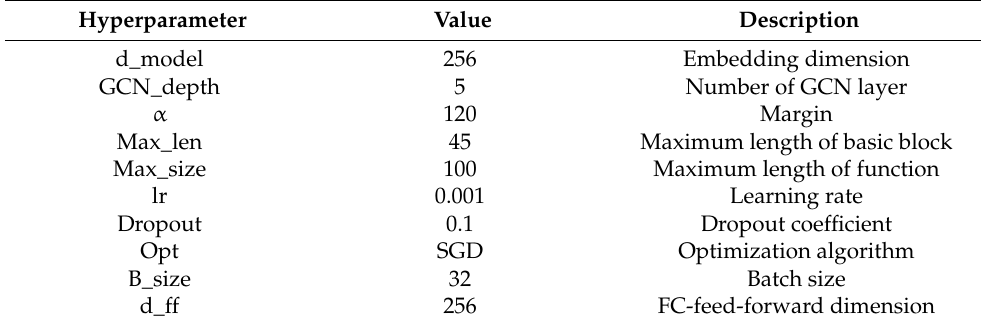
Table 4. Hyperparameters during model